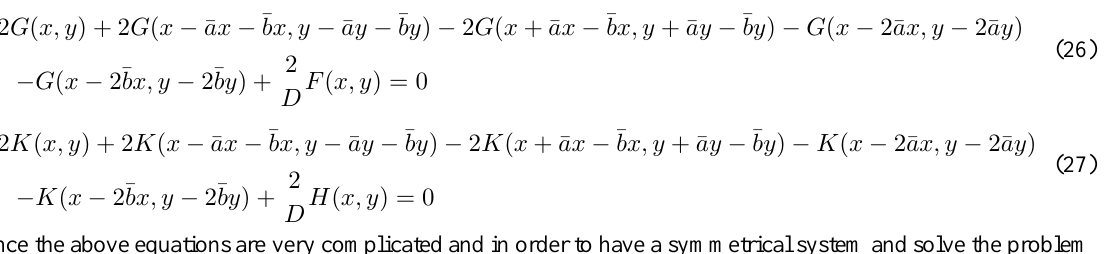
Fig. 3. Damping ratios versus damper locations for the first four eigenfrequencies of non-locally reacting